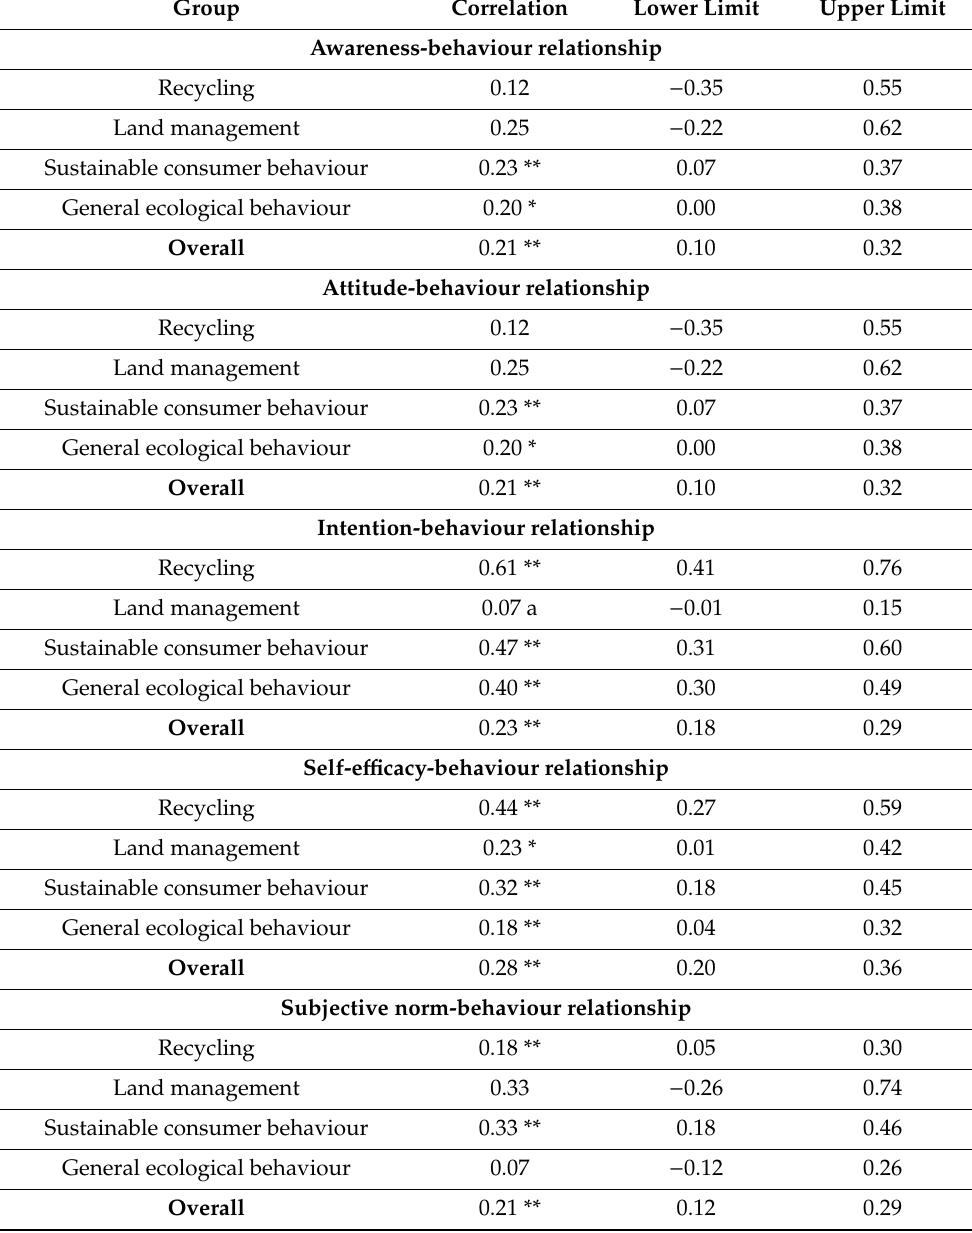
Table 6. Pooled correlations across di ff erent environmental policy areas.